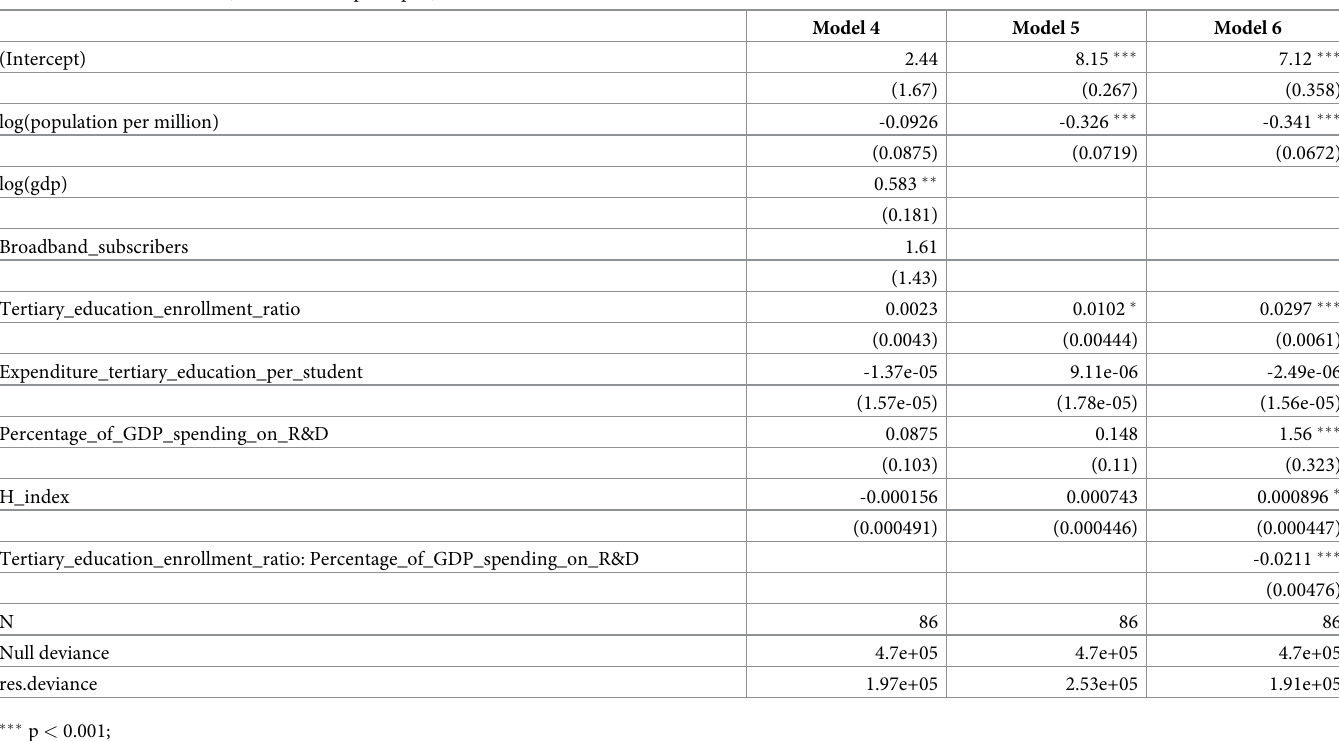
Table 3. Global models II. (DV: download per